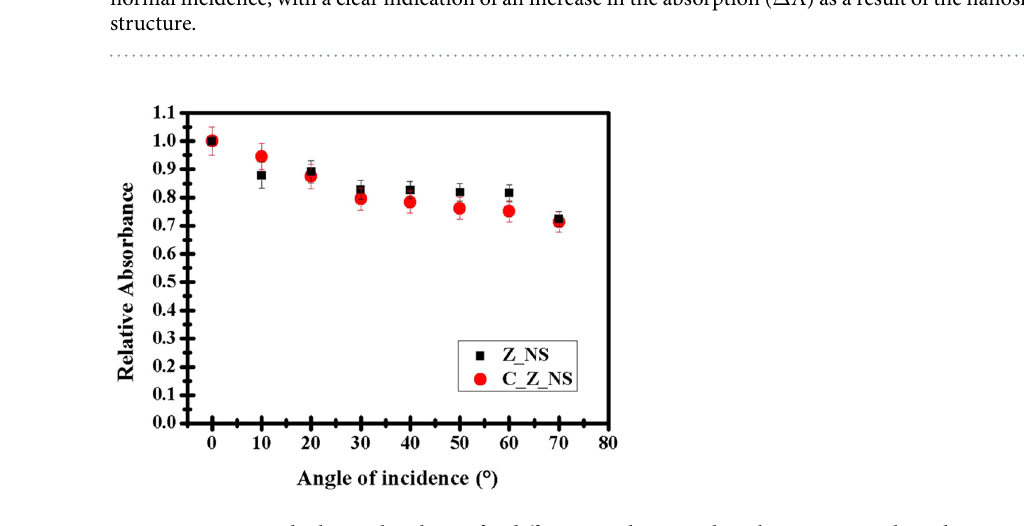
Figure 7. Integrated relative absorbance for different incidence angles relative to normal